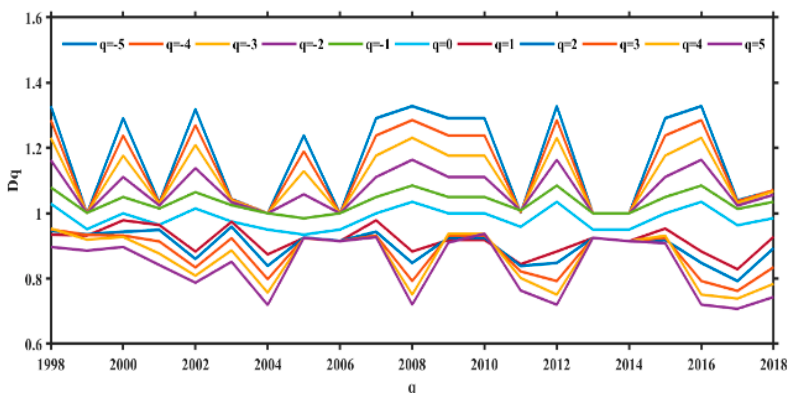
Figure 4. The change state of the fractal curve over time from 1998 to 2018 in the Taiwan region when q is taken from -5 to 5. is taken from − 5 to 5.